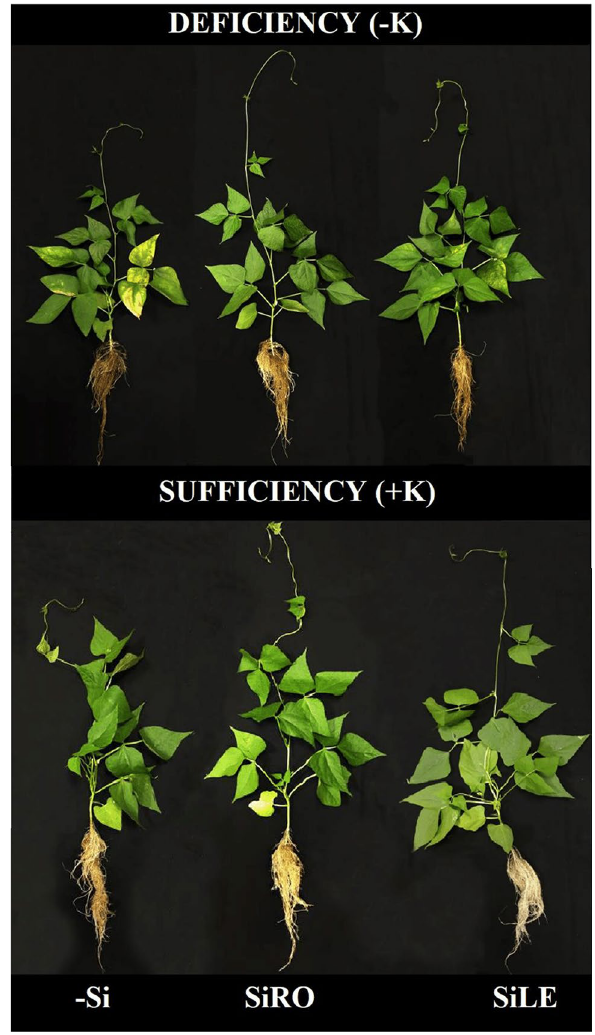
Figure 6. Si effect on shoot and root growth of bean plants cultivated in a hydroponic system under deficiency (–K) and sufficiency (+K) of K, with Si supplied via nutrient solution (root) (SiRO), leaf spraying (SiLE), and control